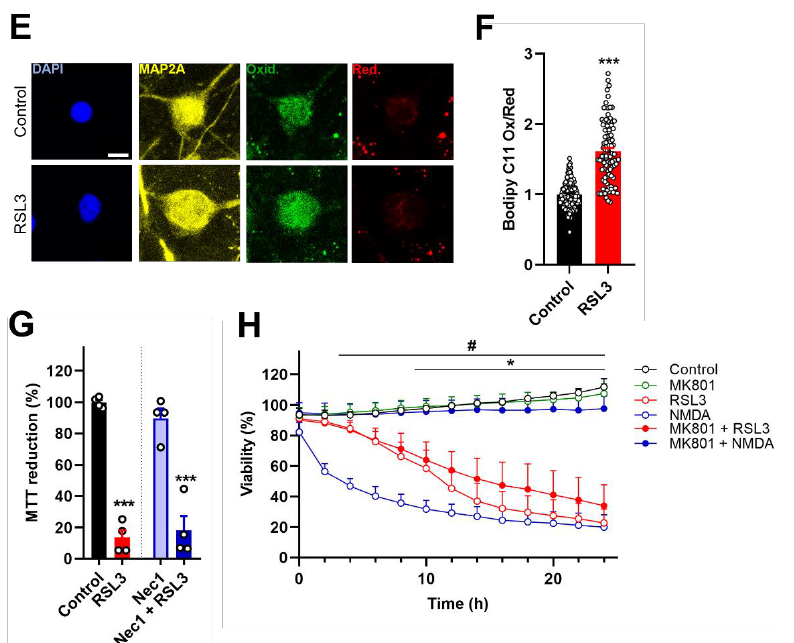
Figure 2. GPX4 inhibition by RSL3 induces ferroptosis in primary hippocampal cultures. ( A – C ). Effects of DFO. ( A , B ). Primary hippocampal cultures were preincubated for 6 h with 100 µ